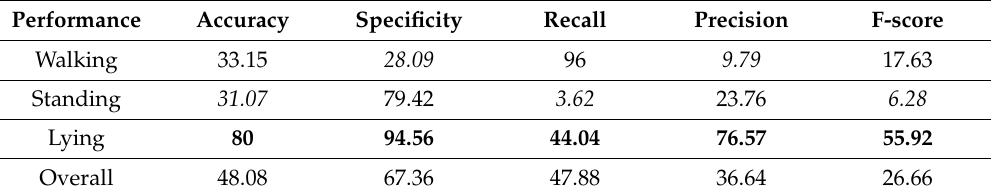
Table 2. Performance of the classification using only prediction from the implemented KNN o ffl ine algorithm. In italics are the lowest values for each measure and in bold is the highest across the di ff erent